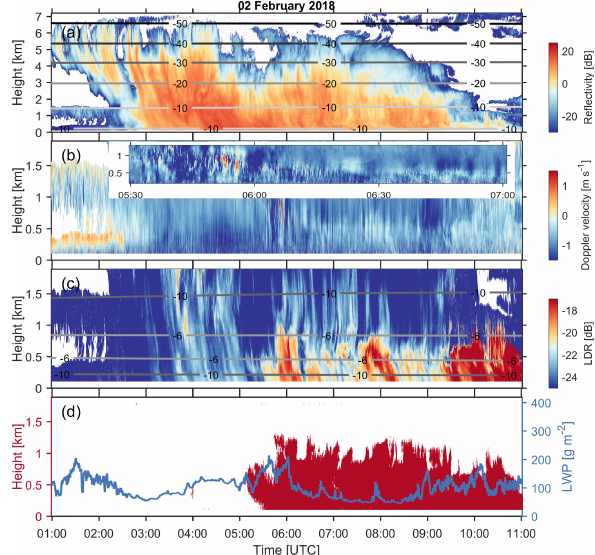
Figure 8. The columnar-ice-producing event recorded on 13 Febru- ary 2018. HYDRA-W observations of (a) equivalent reflectivity factor, (b) mean Doppler velocity, where negative velocity indi- cates downward motion, and (c) LDR. Panel (d) presents the (left axis) detected columnar-ice region and (right axis) LWP observed by HYDRA-W. The lines in (a) and (c) are isotherms produced by ICON. Note that the y -axis scale in (a) is different from that in (b) , (c) and (d) .